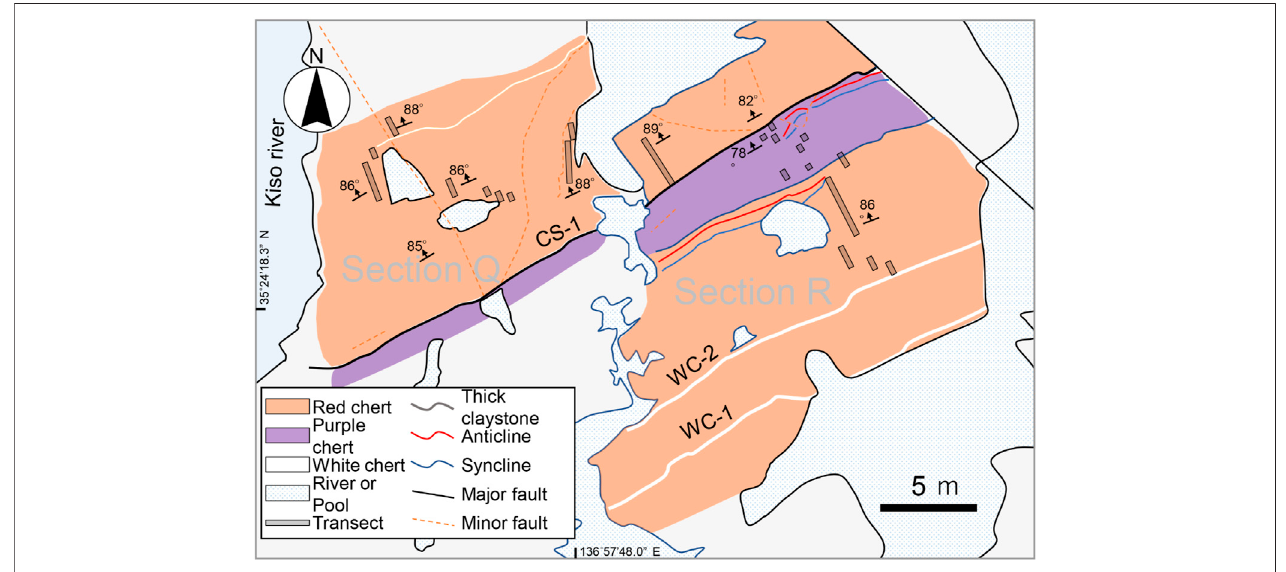
FIGURE 2 | Detailed geologic map of Section R and Section Q of Sugiyama (1997). Continuous composite lithostratigraphy was described in grey lines.